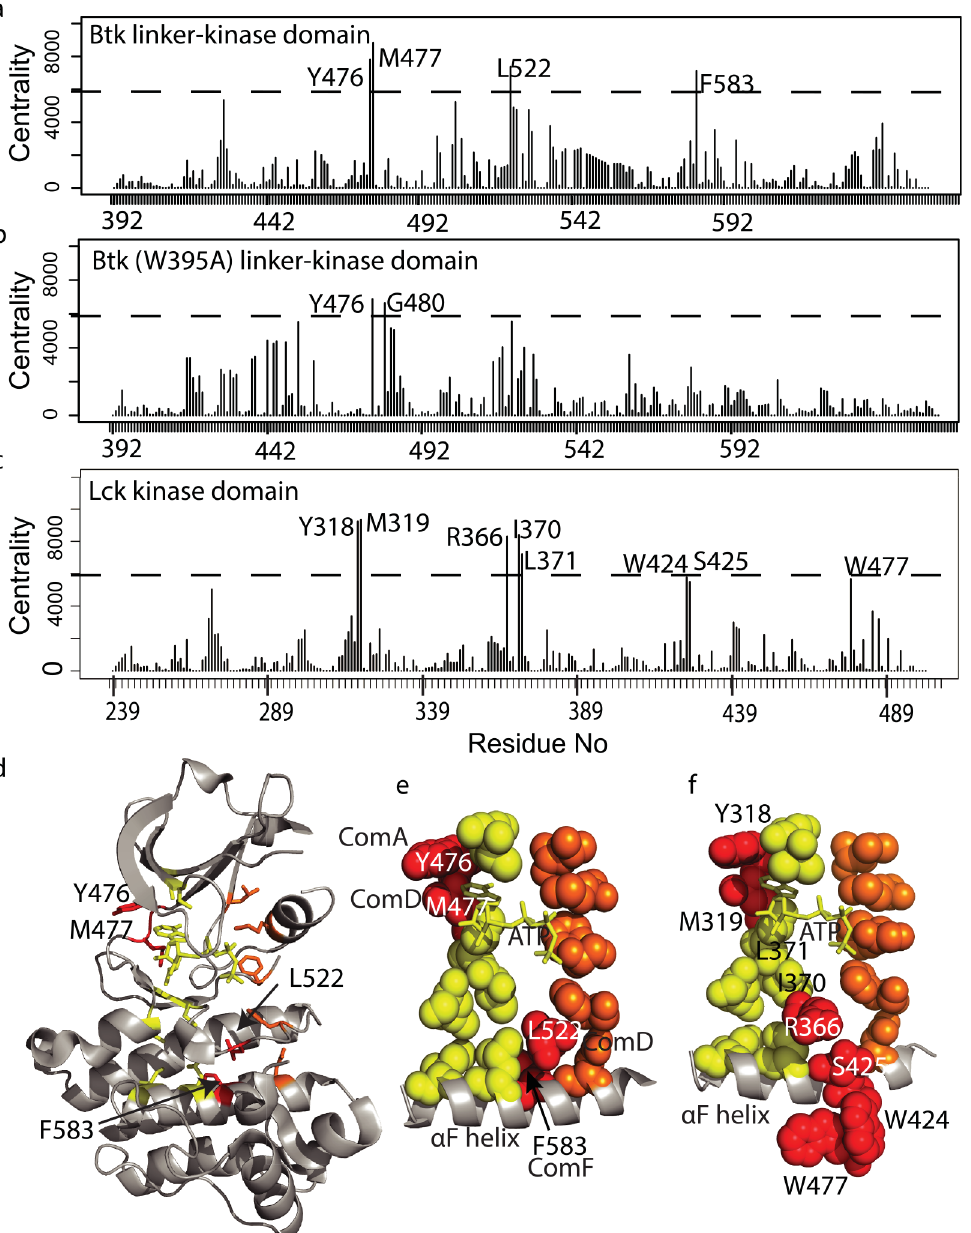
Fig 6. Node-betweenness centrality index values reveals residues that bridge the R- and C-spines. (a-c) Node-betweenness centrality index plot for Btk linker-kinase (a), Btk (W395A) linker-kinase domains (b) and Lck kinase domain (c). The threshold (dotted line) was set for Btk linker-kinase (a), such that 98.5% of the centrality index values are below the threshold value. The same threshold is used for Btk (W395A) linker kinase in (b) and Lck in (c). In (a) and (c) the centrality value for one residue, A428 in Btk and A271 in Lck, nearly reaches the threshold but was not included in our analysis since this residue is part of the previously defined C-spine in both kinases. (d) High centrality residues from (a) are mapped onto the structure of active Btk (3K54), labeled, and colored red. C-spine residues are yellow and R-spine residues are orange as in Fig 1B. (e) Spheres define the residues of the C-spine (yellow), R-spine (orange) and the newly identified bridging residues (red). The α F-helix is shown and ATP within the C-spine is depicted in stick form. The communities (Fig 5) of each of the four bridging residues are indicated. (f) High centrality residues in Lck (shown in (c)) are mapped onto the structure of the active Lck kinase domain (3LCK), labeled and colored red. As in (e) Lck C-spine residues are yellow and R-spine residues are orange, the α F-helix is shown and ATP is shown in stick form. I370 and L371 are high centrality residues in Lck (see (c)) and are part of the previously defined C-spine and therefore colored